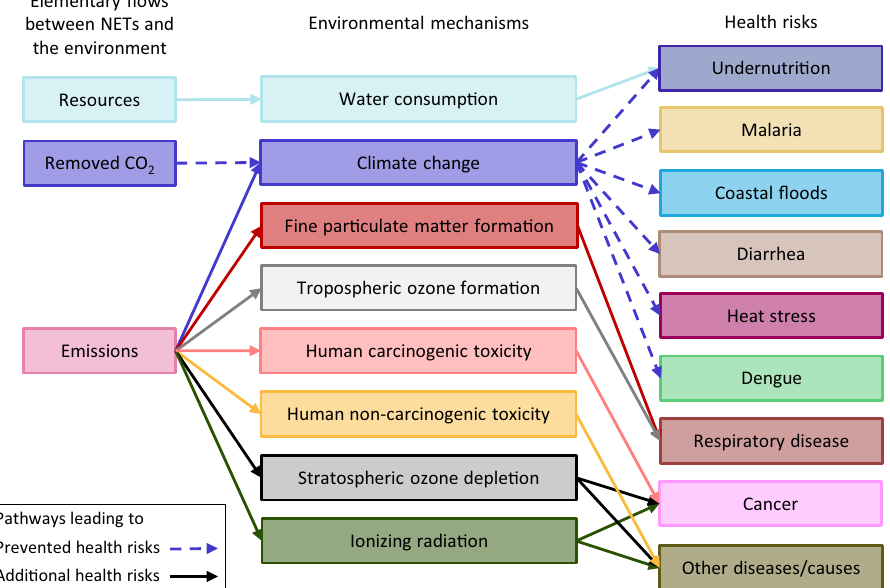
Fig. 2 Streamlined human health damage pathways of Negative Emissions Technologies (NETs). These pathways are consistent with the cause-and- effect chains considered by the ReCiPe 2016 method 67 and Tang et al. 71 . Dashed and solid arrows lead to prevented and additional health risks, respectively, relative to the